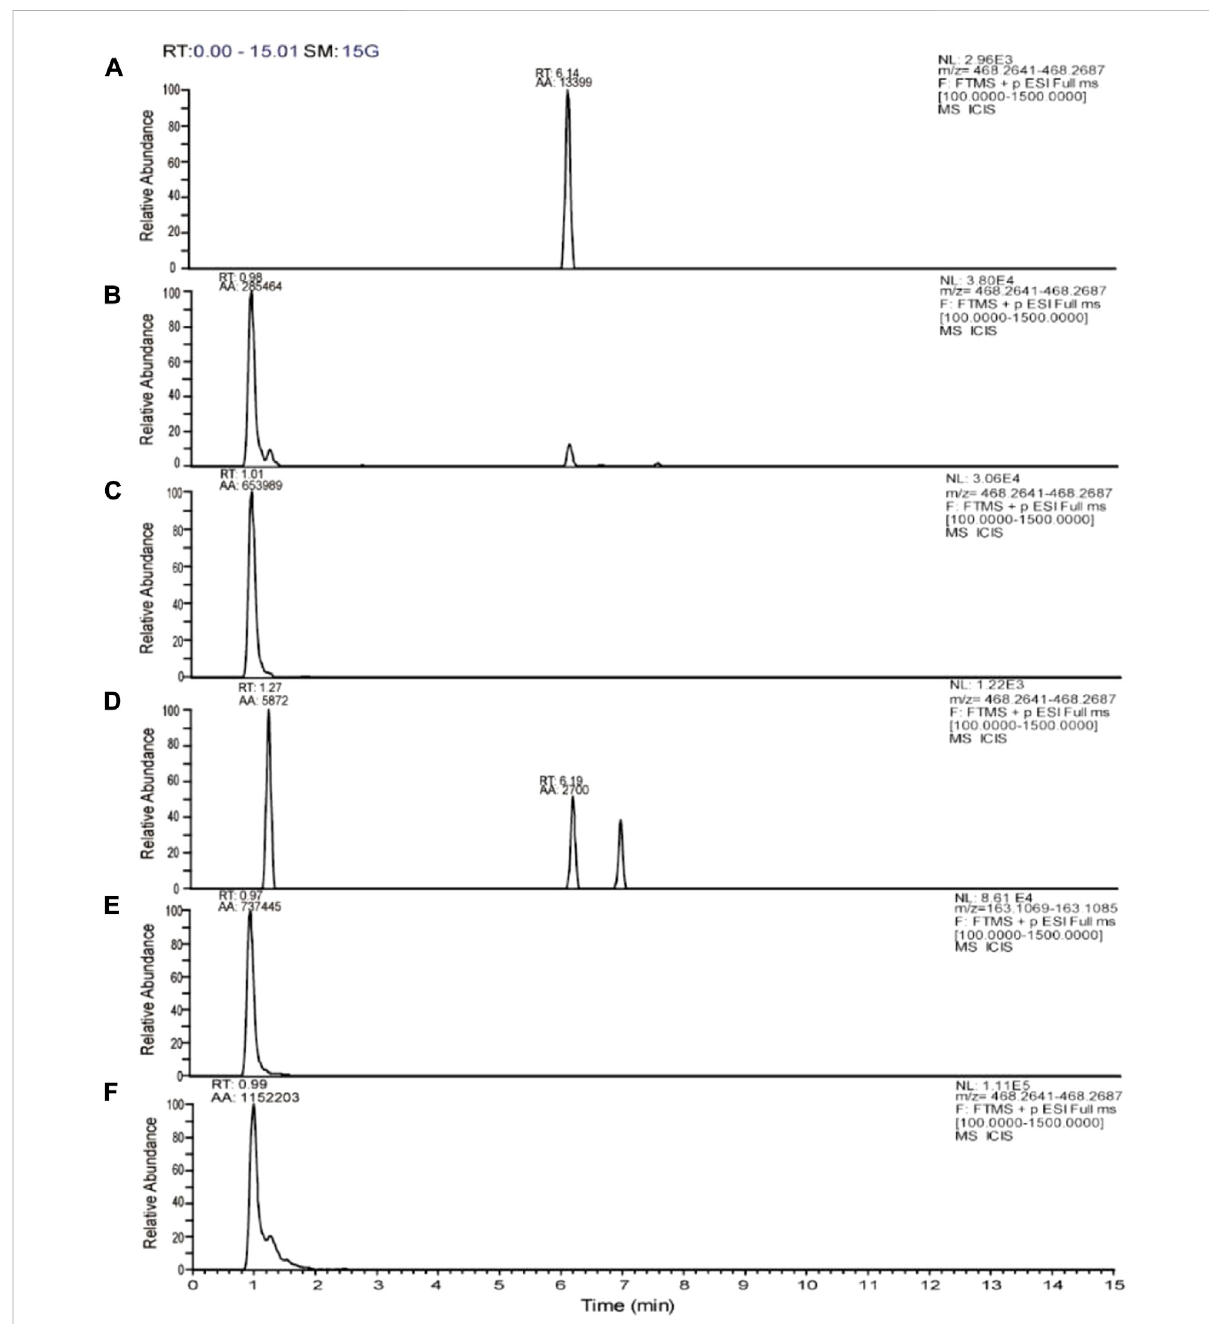
FIGURE 5 Representative extracted ion chromatograms (EICs) of tobramycin obtained from (A) ATCC27853 broth group (B) ATCC27853 TOB group (C) ATCC27853 DHA27 + TOB group (D) PA16 broth group (E) PA16 TOB group (F) PA16 DHA27 + TOB